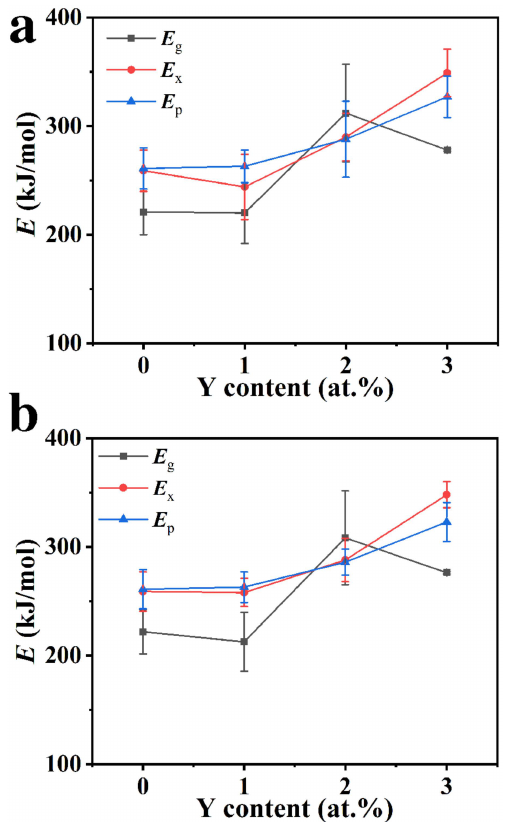
Figure 6. Plots of activation energies vs. different yttrium doping contents: ( a ) Kissinger fitting and ( b ) Ozawa